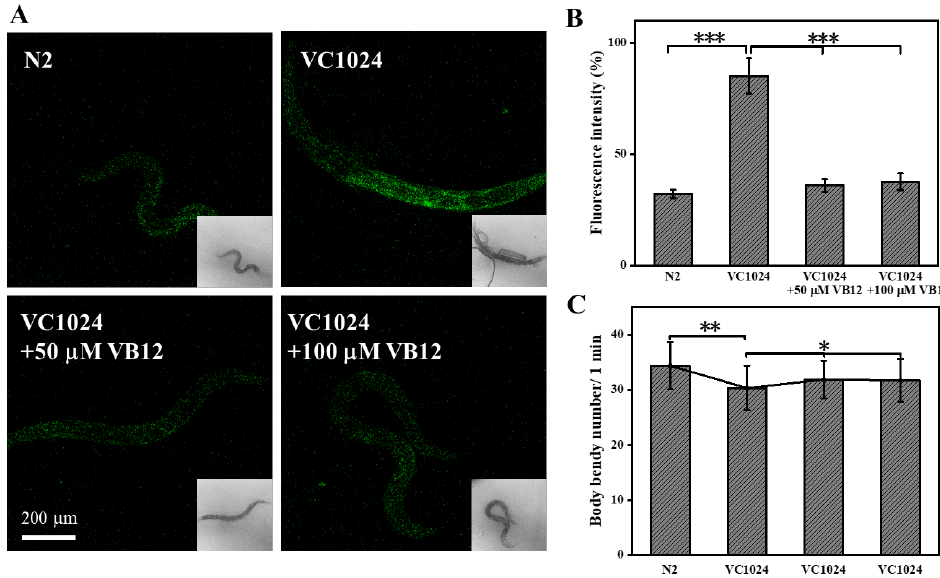
Figure 5. VB12 relieves symptoms of PD C. elegans . ( A ) Fluorescent intensity of ROS in wild-type (N2) and PD C. elegans (VC1024) with and without VB12 treatment; ( B ) quantification of the fluorescence intensity of the ROS probe shown in (A); ( C ) the number of sinusoidal torsion in C. elegans of wild- type and PD with/without VB12 treatment. Scale bar = 200 µ m. Data are the mean ± SEM, n = 30. * p < 0.05, ** p < 0.01, *** p < 0.001 compared with other